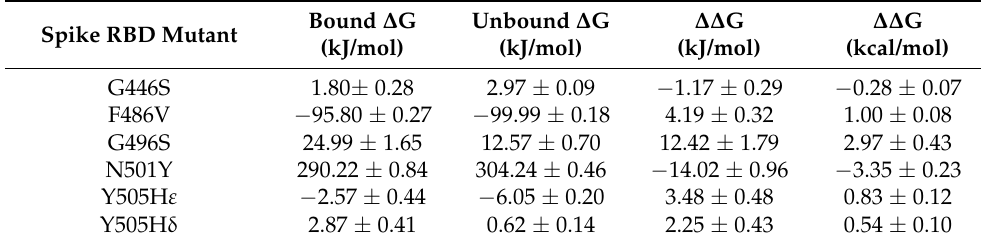
Table 2. Binding free energies towards hACE2 for the studied SARS-CoV-2 spike RBD mutants obtained from alchemical free energy